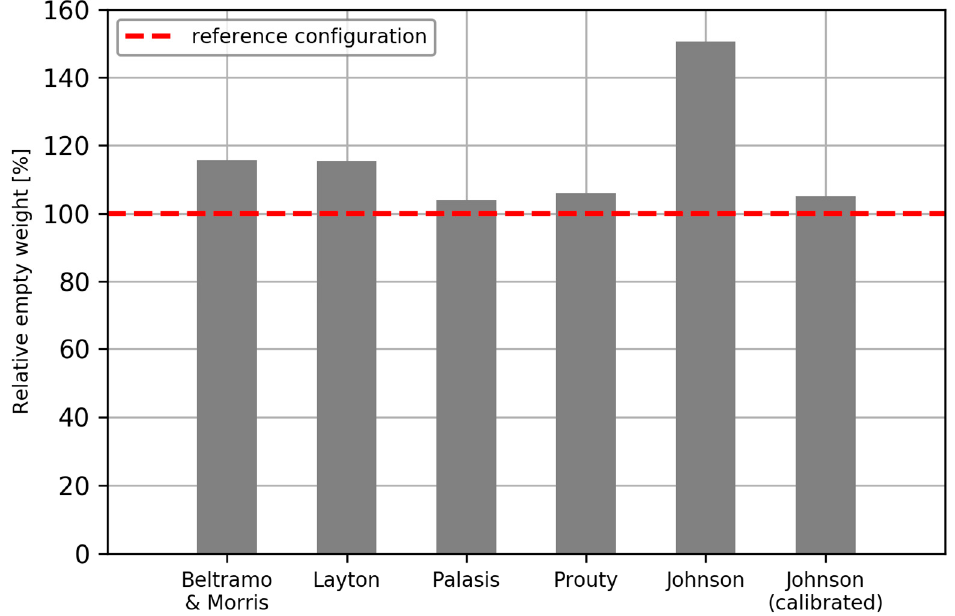
Figure 12. Bo105 BEM computation by different methods.